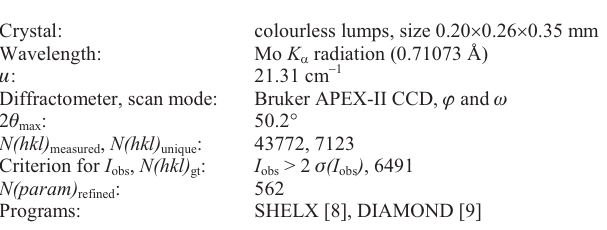
Table 1. Data collection and handling.